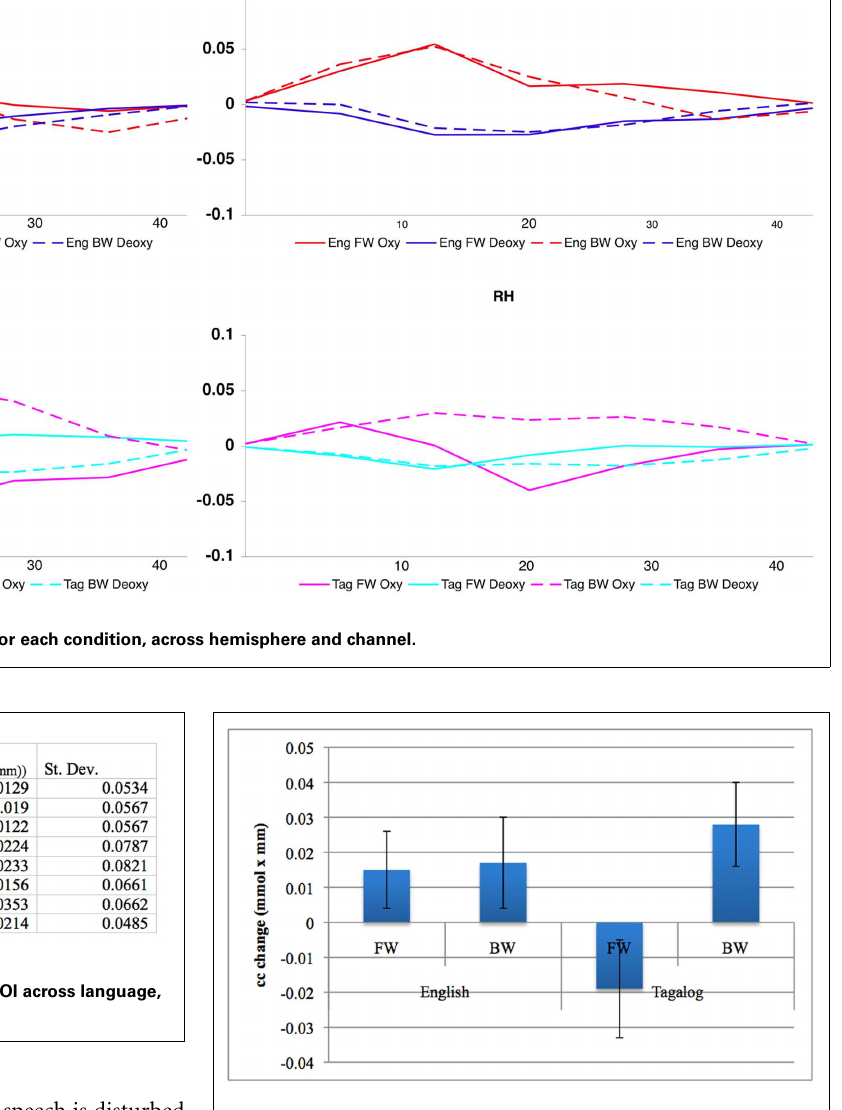
FIGURE 7 |The Language by Direction interaction in oxyHb activation obtained in the experiment. Error bars represent SE of the